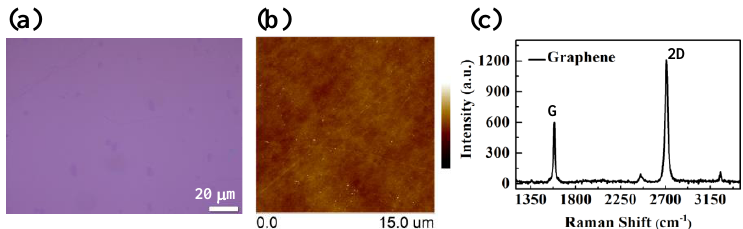
Figure 1. ( a ) Optical and ( b ) Atomic force microscopy (AFM) images of chemical vapor deposition (CVD)-grown graphene that is transferred onto SiO 2 /Si substrate; ( c ) showing the Raman spectrum of the as-transferred graphene. The color scale of AFM image is − 20–20